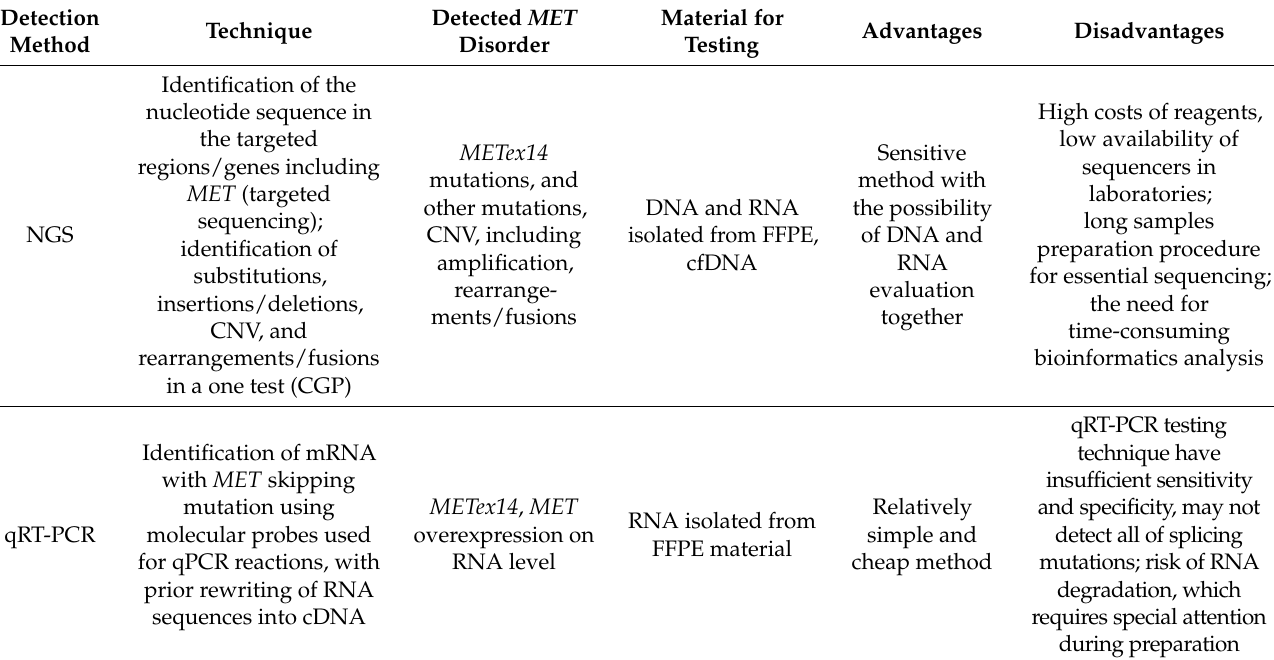
Table 1. Summary technique used to MET abnormalities